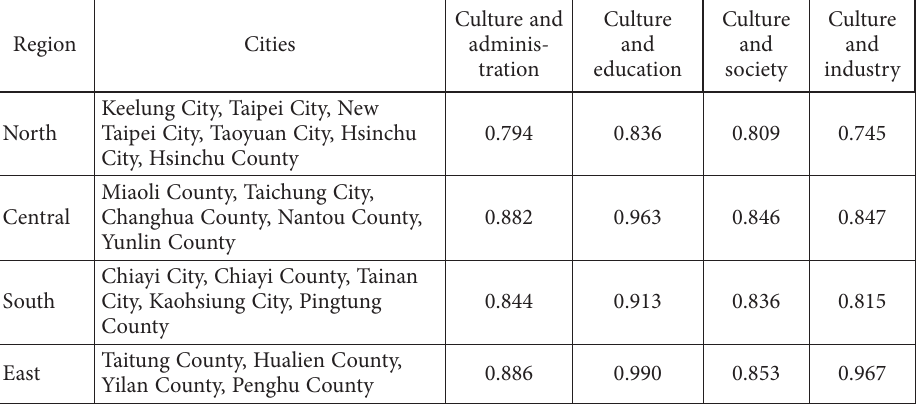
Table 4. Grey relational coefficients of the four dimensions in the four regions Region Cities